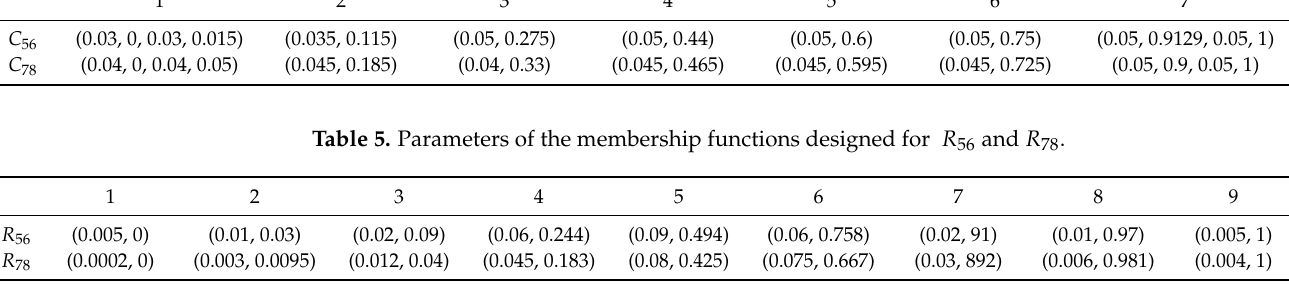
Table 6. Parameters of the membership functions designed for R 56 (cid:48) and R 78 (cid:48) .